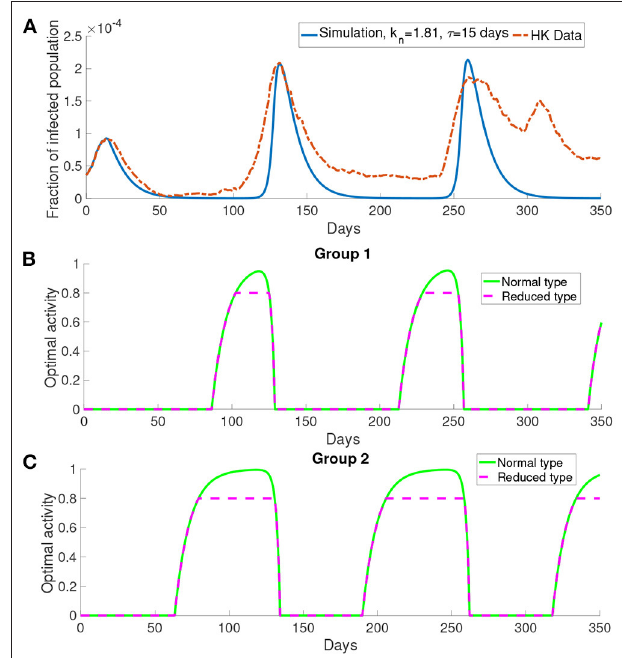
FIGURE 8 | The simulation result with M = 2 and transmission rates in the form of Equations (18) and (17). (A) The comparison of the infected population in the simulation with the data. (B,C) The optimal activity of the two